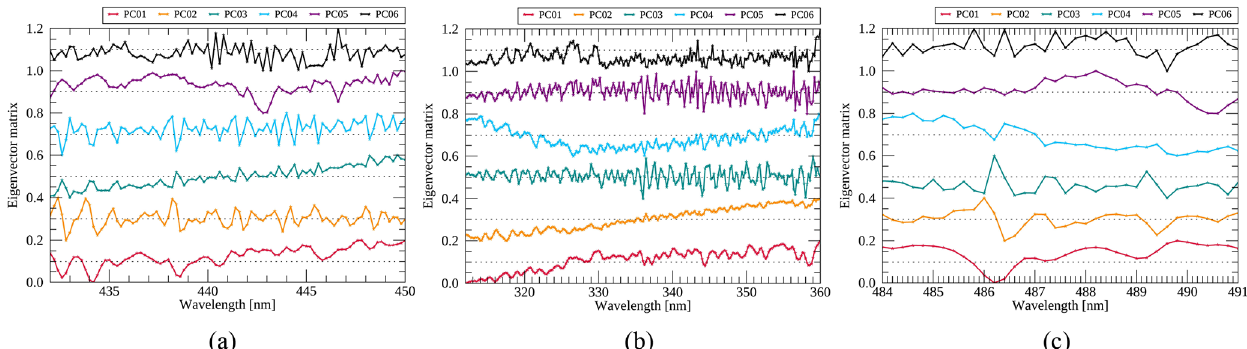
Figure 11. Eigenvector of the first six PCs applied to GEMS radiances for the target wavelengths of (a) Defects 1, (b) Defect 2 and (c) De- fect 3. All eigenvectors are scaled (min–max scaling) and shifted for clarity of presentation.